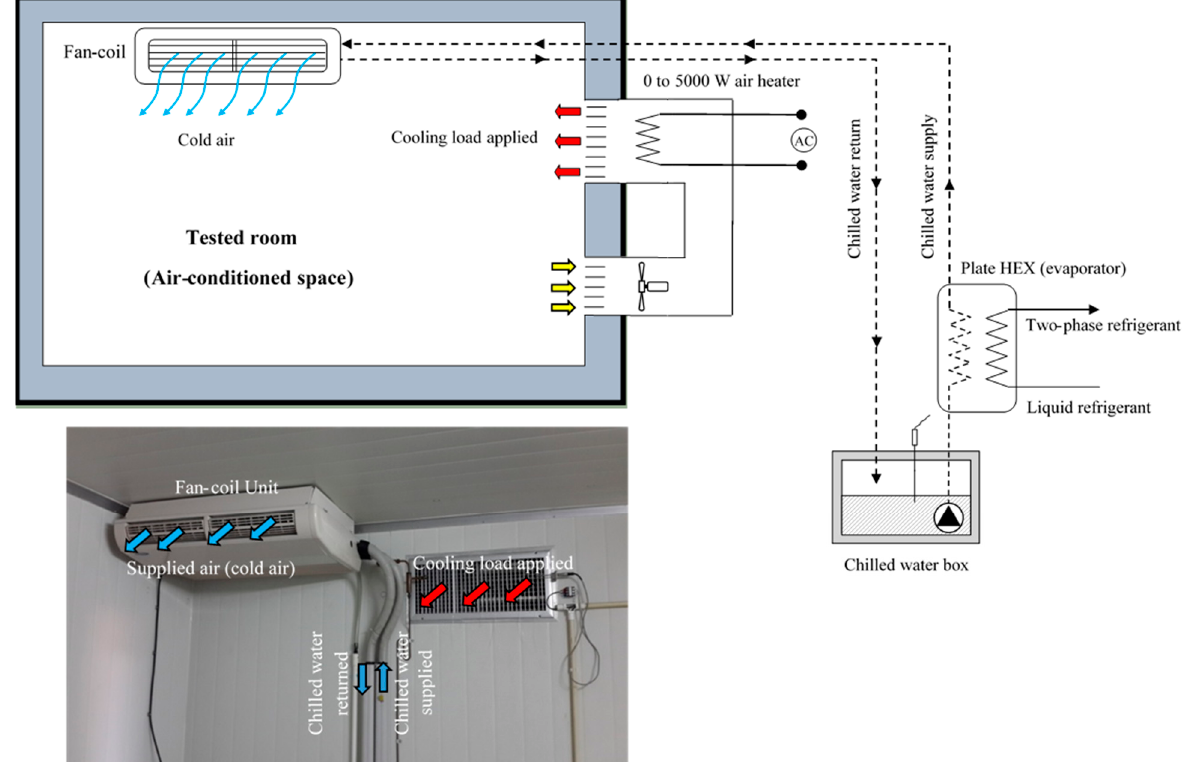
Figure 3. A schematic view of the air-conditioning test.